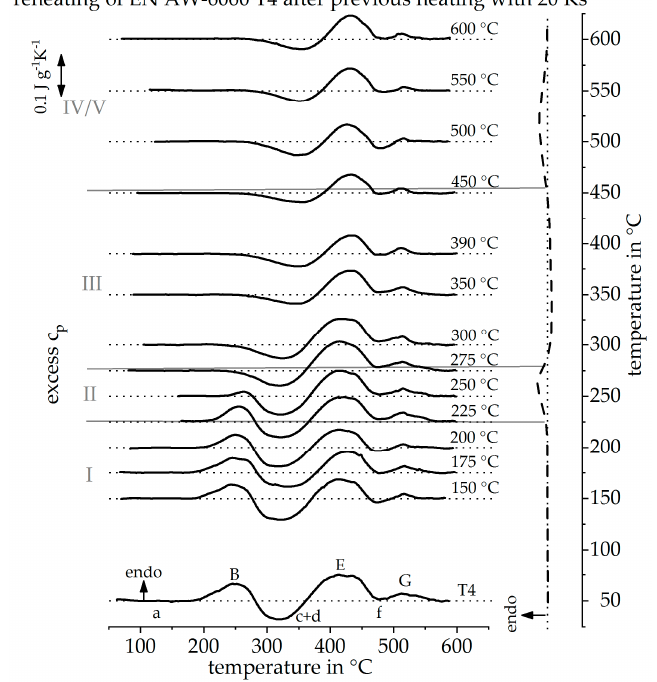
Figure 14. Reheating curves of the alloy EN AW-6060 T4 after a heat treatment with a heating rate of 20 Ks − 1 up to different maximum temperatures and the resulting reconstructed DSC heating curve at 20 Ks − 1 . Materials 2019 , 12 , x FOR PEER REVIEW 17 of 22